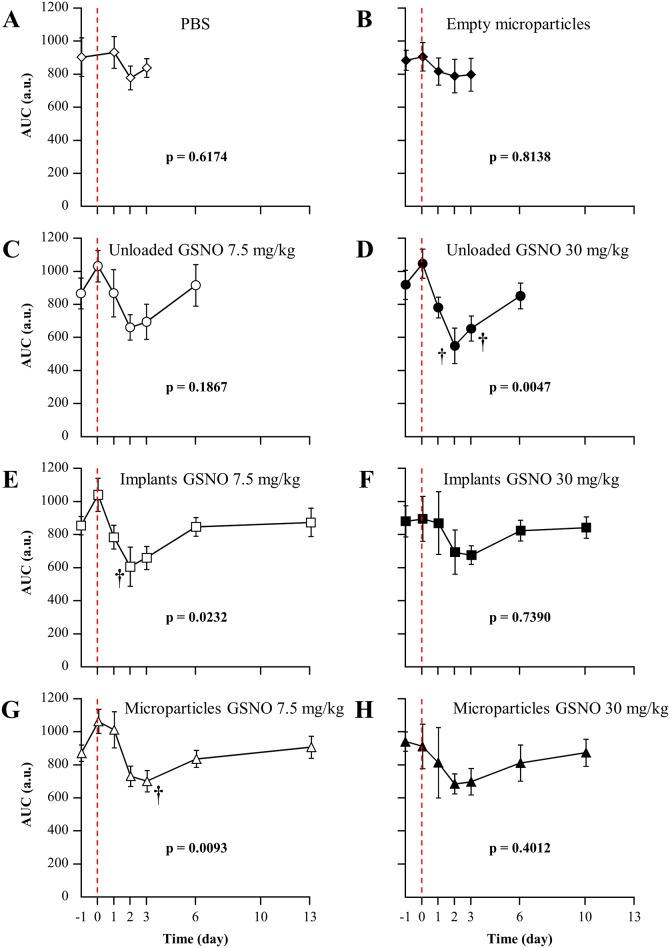
Impact of the treatments on whole blood platelet aggregation (aggregometry AUC).Treatments were: PBS (n = 6), empty microparticles (n = 8), free GSNO at 7.5mg/k g(n = 5) or 30 mg/kg (n = 5), in situ implants loaded with 7.5 ± 0.8 mg/kg (n = 7) or 32.1 ± 4.3 mg/kg (n = 10) of GSNO and in situ microparticles loaded with 7.9 ± 0.6 mg/kg (n = 7) or 31.4 ± 3.6 mg/kg (n = 10) of GSNO. The red vertical dashed lines represent the time of injection. †: p < 0.05 vs. 1 h following substance administration within the same group (one-way ANOVA; post-hoc Bonferroni test).